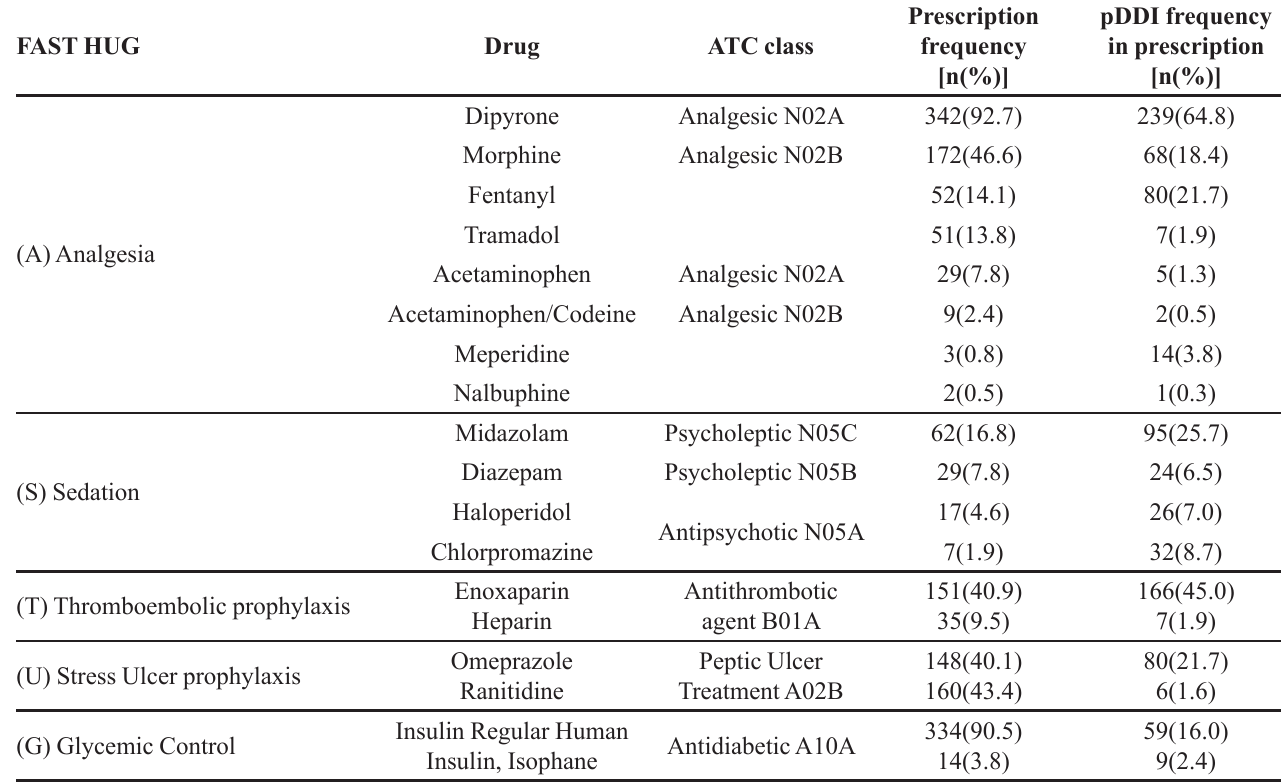
TABLE II - Prescribed drugs related to FAST HUG and their potential Drug-Drug Interactions (pDDIs)